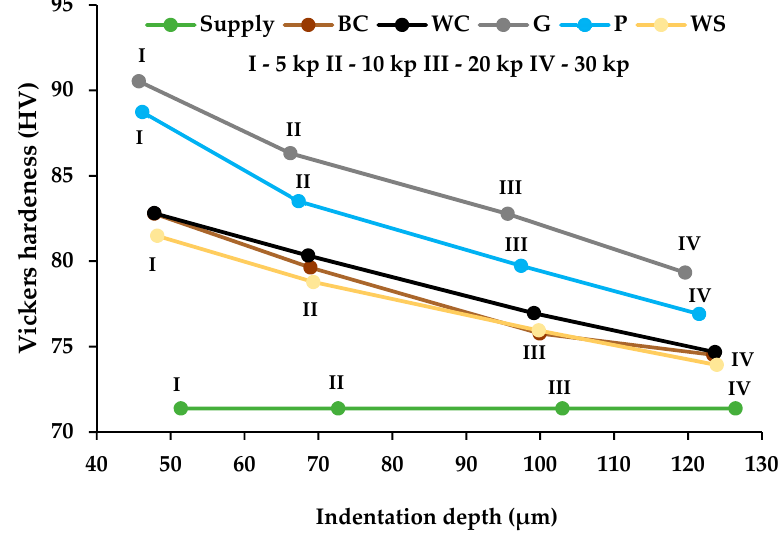
Figure 6. Vickers hardness with loads 5, 10, 20, and 30 kp versus penetration depth in ENAW5182 aluminium substrate, after sandblasting with various abrasives between 0.4 to 0.6 MPa for PTFE stripping.